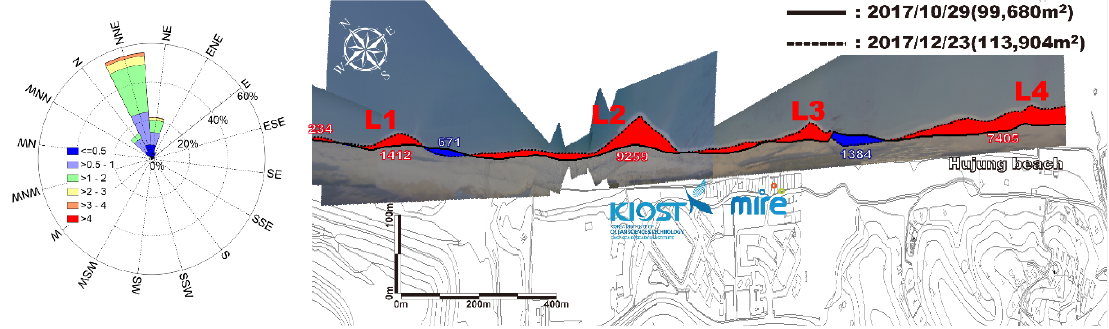
Figure 8. Same comparison as that in Figure 6 but measured at the beginning (29 October 2017) and end (23 December 2017) of T3. end (23 December 2017) of